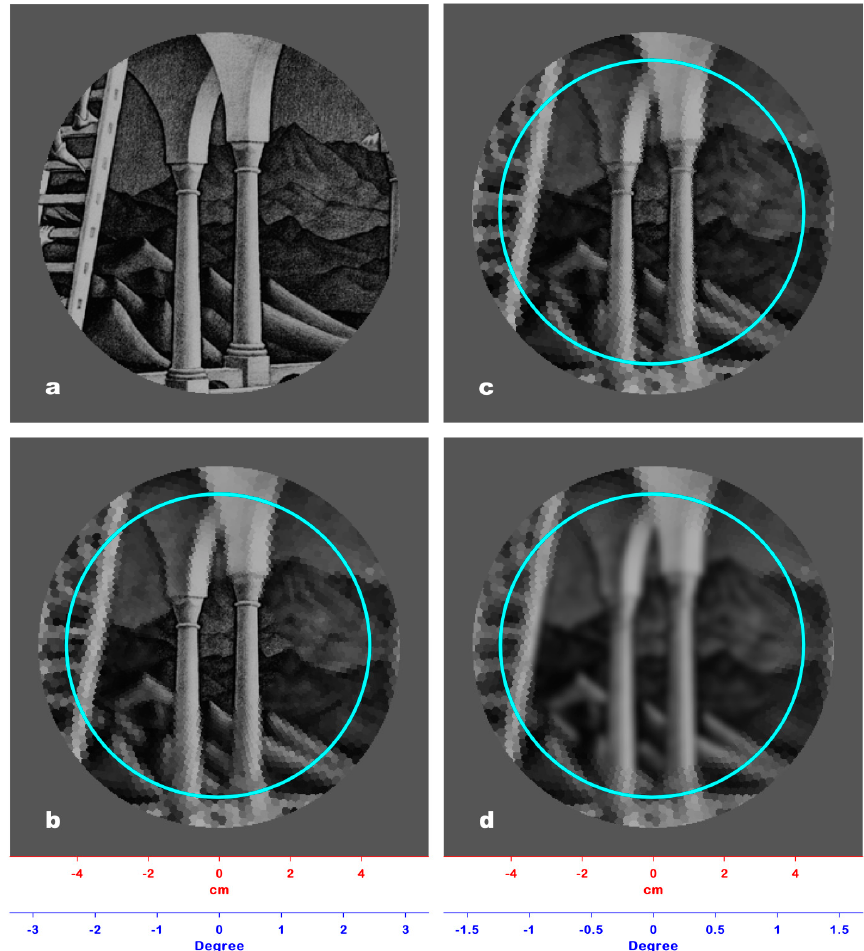
Figure 5. ( a ) The result of Experiment #4: The Belvedere lithograph is overlaid with a window of a 51.6 mm radius, which allows the perception of 3D incoherence in a free viewing mode at a 1 m observation distance. ( b ) The PRI of Figure 5a: The spatial resolution outside the limit of the pre-attentive perception window (42.80 mm, cyan line) is too low to allow the perception of 3D incoherence. ( c ) The PRI of Figure 5a viewed at a 0.5 m distance: At this distance, the perception of 3D incoherence is also hindered by the low spatial resolution outside the pre-attentive perception window. ( d ) The PRI of Figure 5a viewed at a 2 m distance: The spatial resolution outside the pre-attentive perception window is still too low to allow perception of any incoherence.